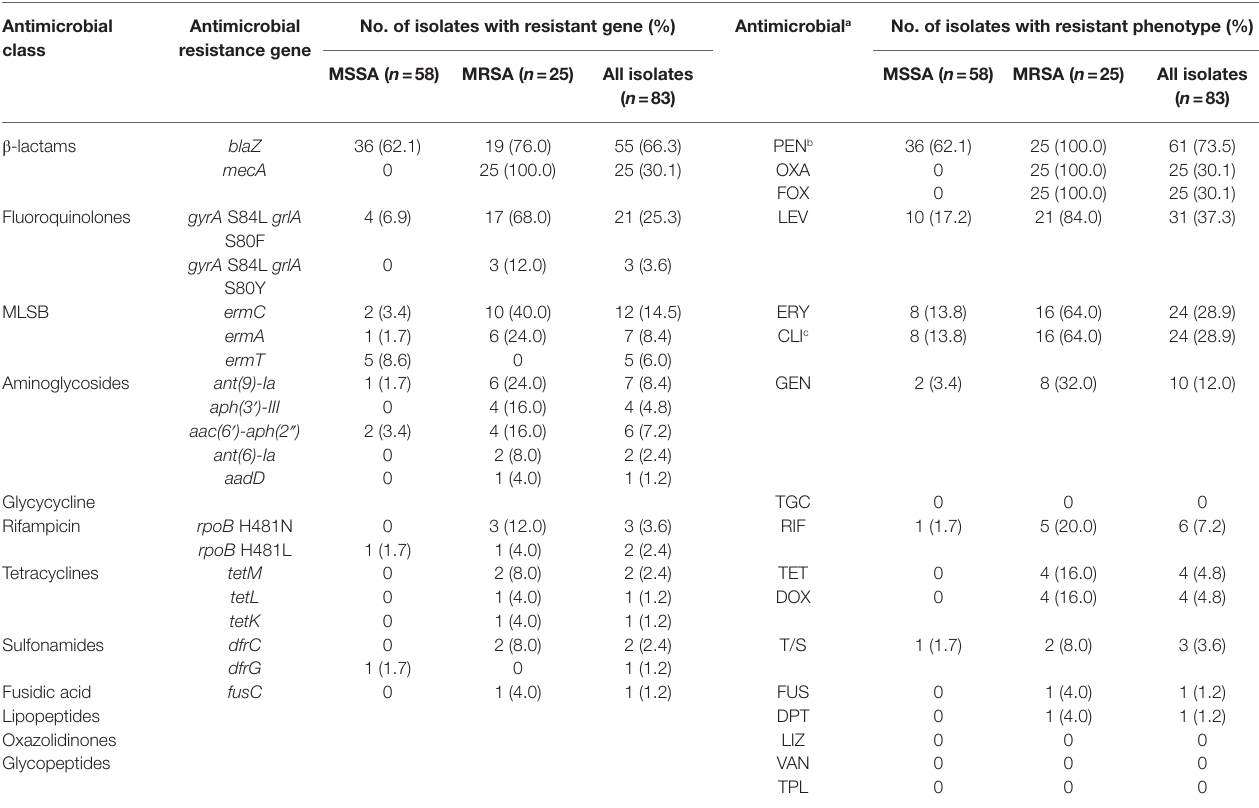
TABLE 2 | Resistance genes and antimicrobial-susceptibility profile in 83 Staphylococcus aureus isolates from OM. Antimicrobial Antimicrobial No. of isolates with resistant gene (%) Antimicrobial class resistance gene